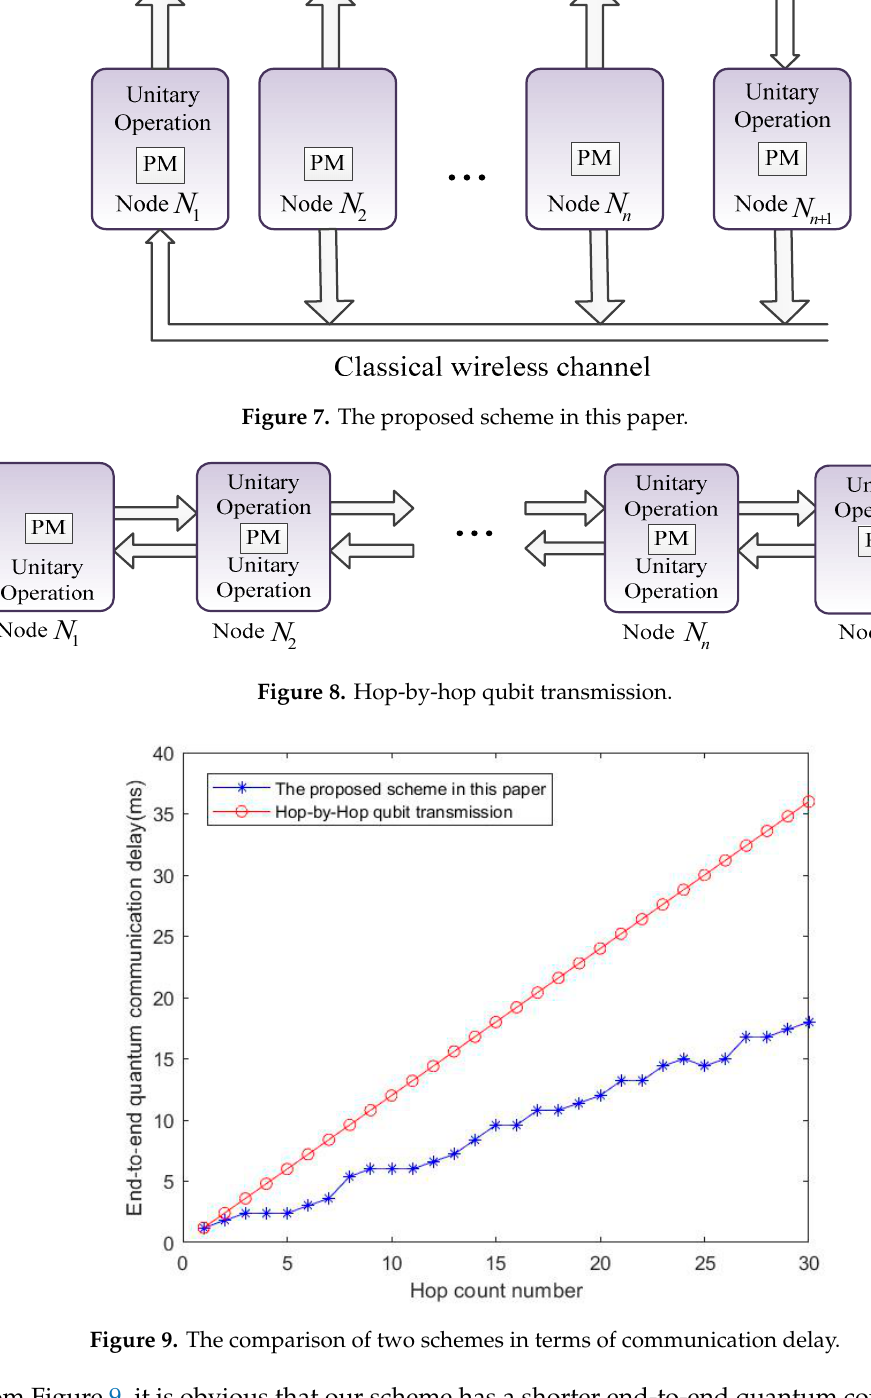
Figure 9. The comparison of two schemes in terms of communication delay.